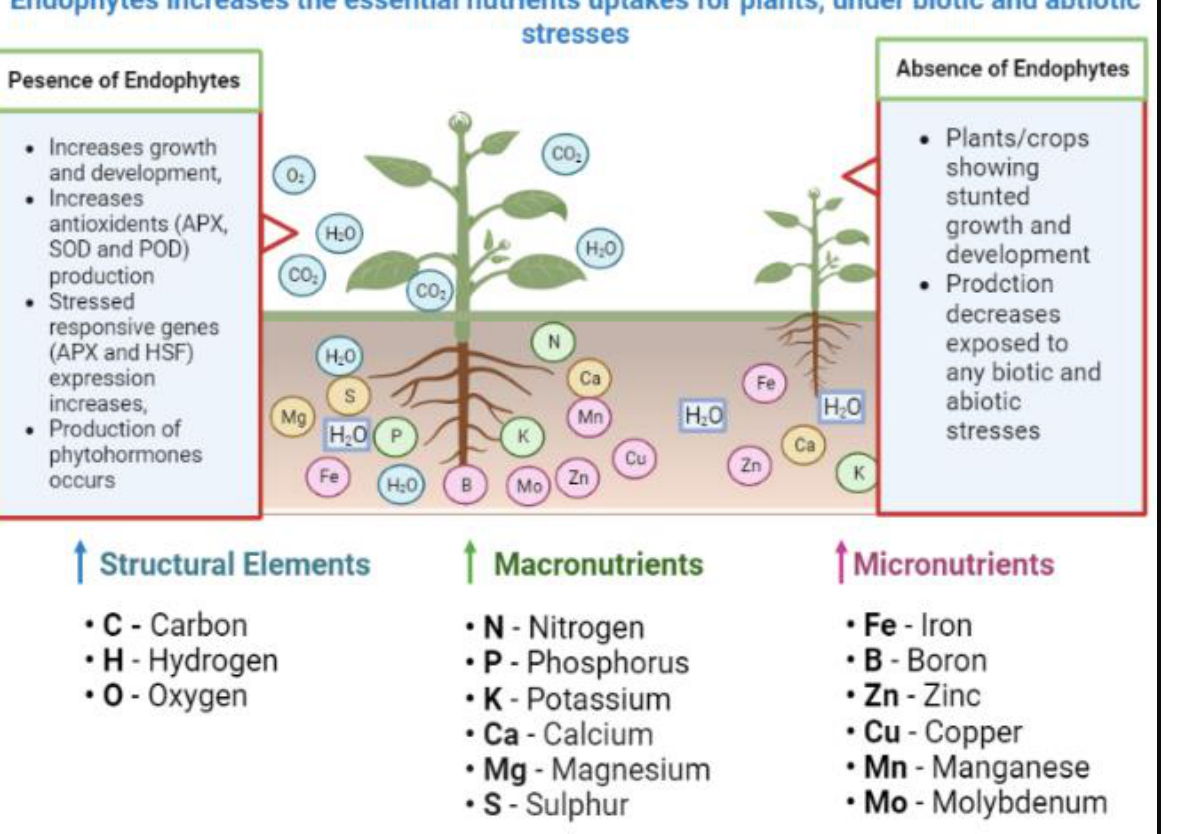
Table 1. Summary of documented researches on the endophytes from Parthenium hysterophorus L. and its role in different biotic and abiotic stresses.